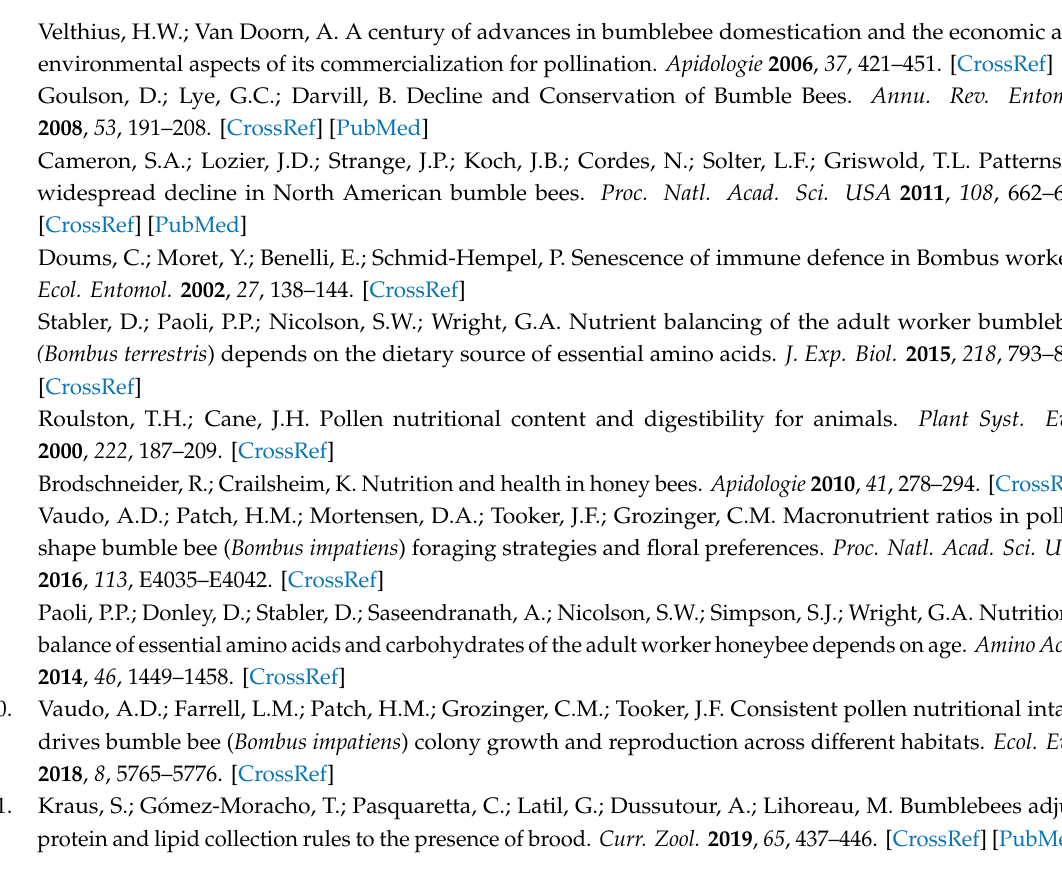
Table S1: Summary of statistical analyses. The data with normal distribution (total concentration of carbohydrates, lipids, proteins and hemocytes) were analysed using one-way ANOVA with post-hoc Tukey’s test, whereas Kruskal-Wallis with post-hoc Dunn’s test was used to analyse data without normal distribution (antioxidant activity, constitutive and induced antimicrobial activity). Significant p values < 0.05 are highlighted in bold. * F or H statistic is reported for ANOVA and Kruskal-Wallis test, respectively. Table S2: Summary of t tests that were used to analyse phenoloxidase activity in the hemolymph of Bombus terrestris workers. The constitutive phenoloxidase activity (PO) and total phenoloxidase activity measured after enzymatic cleavage of prophenoloxidase (pPO) were analysed in control and foraging B. terrestris